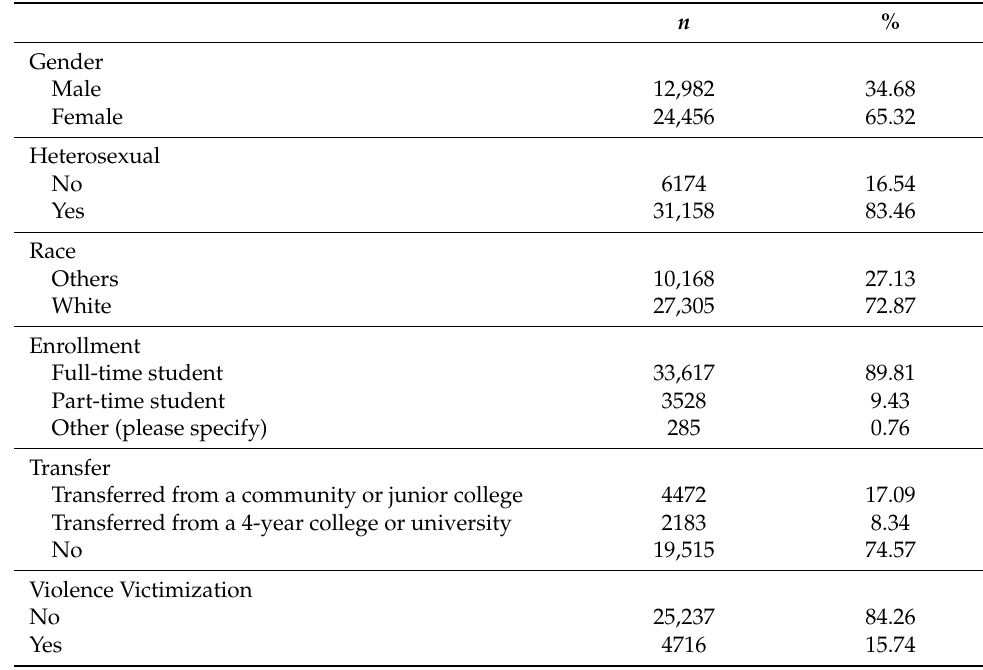
Table 1. Descriptive characteristics in the participants.